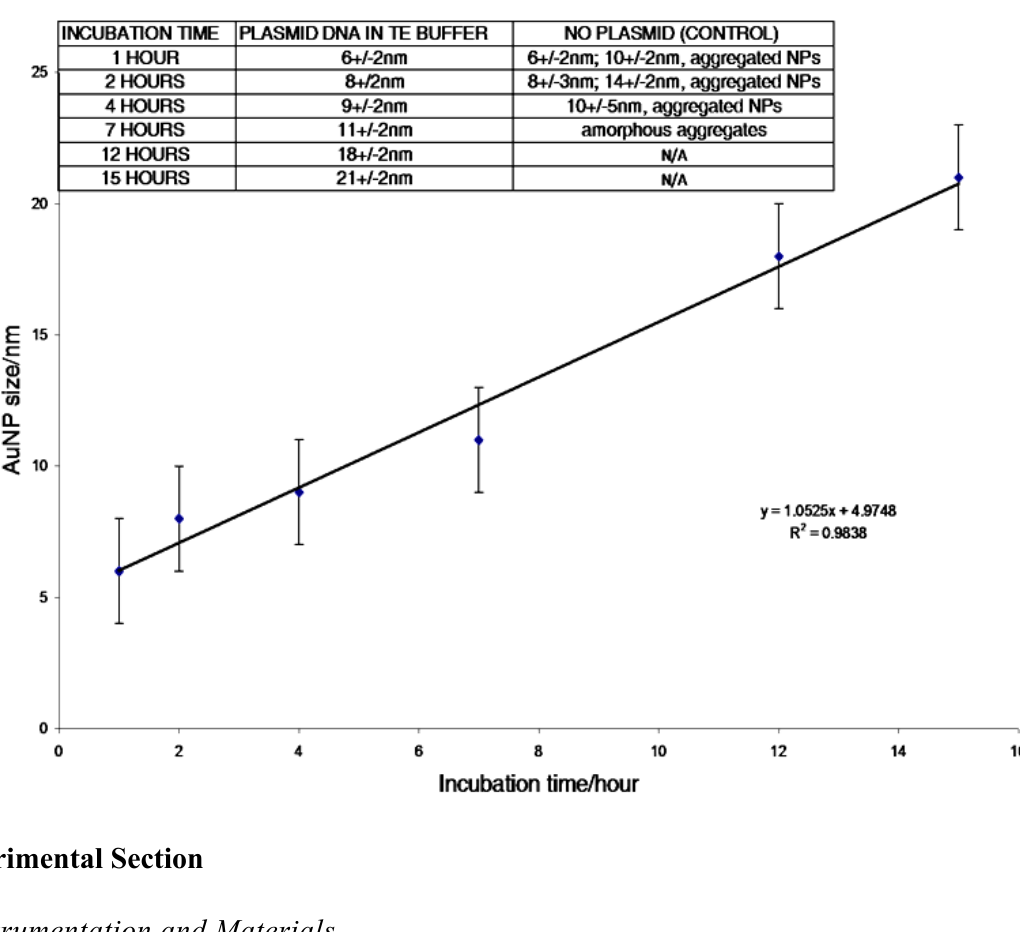
Figure 1. Incubation time of the gold phosphine precursor with plasmid DNA versus NP size determined by TEM